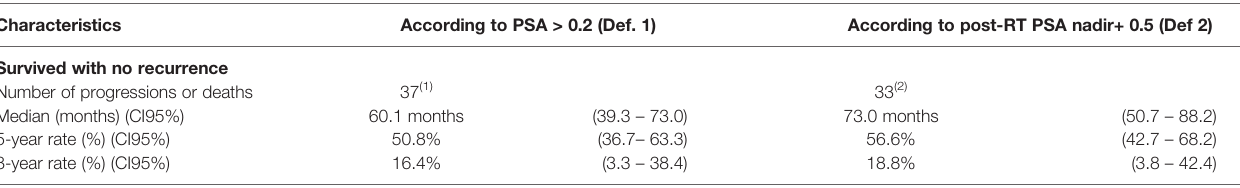
TABLE 4 | Biochemical progression-free survival.